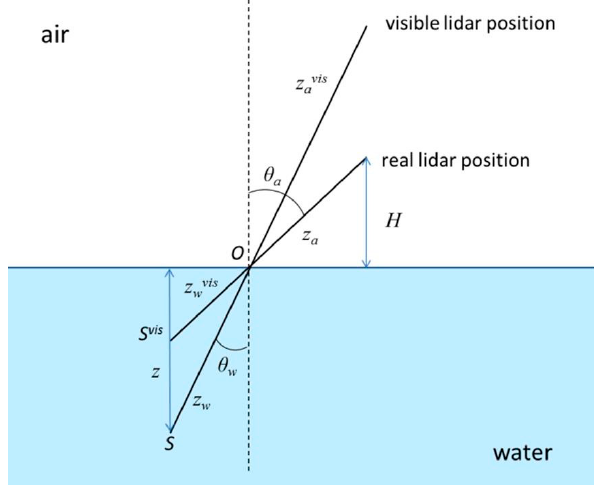
Figure 1. Schematic of an oceanic lidar experiment.